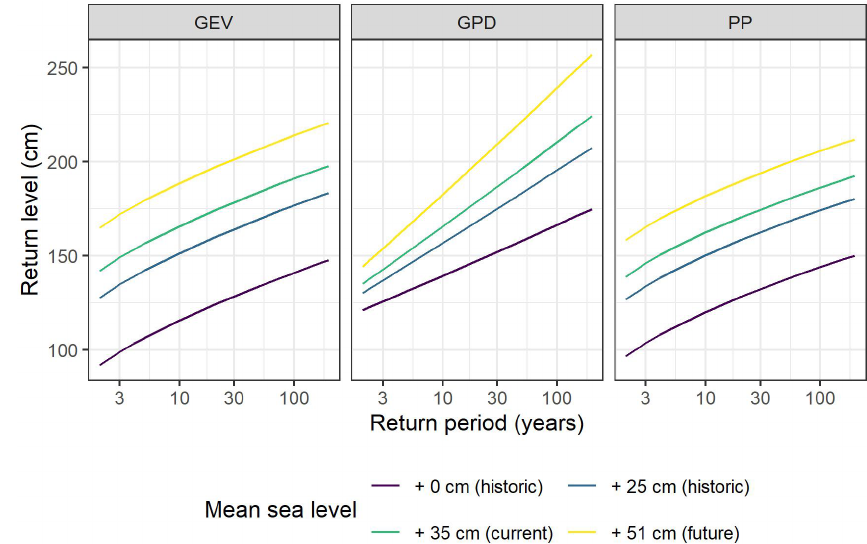
Figure 6. Return level plots for different values of mean sea level. Mean sea level is expressed with respect to the local reference. The current mean sea level is + 35cm for Venice and + 54cm for Marseille. See Sect. 2.4 for a description of the selected future mean sea